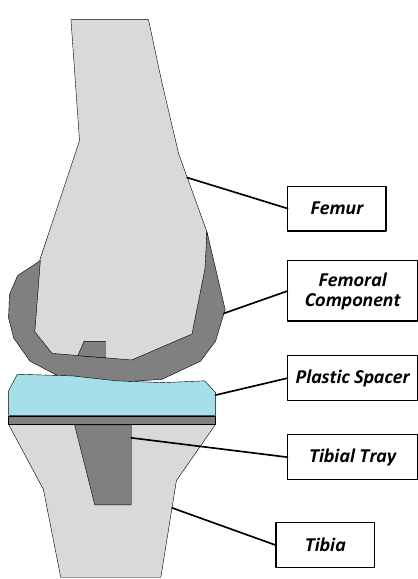
Figure 1. A total knee replacement prosthesis (side view).